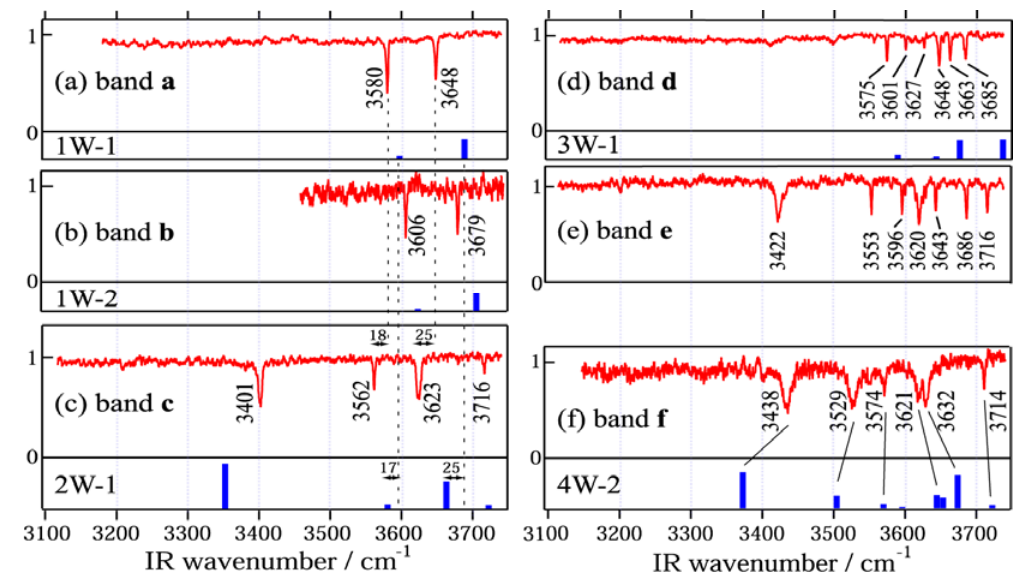
O) measured by monitoring bands a - 2 n